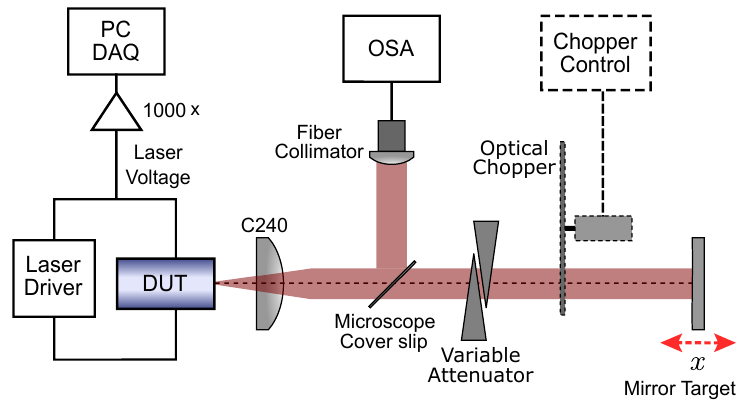
Figure 2. Experimental setup used to evaluate SM in the tested